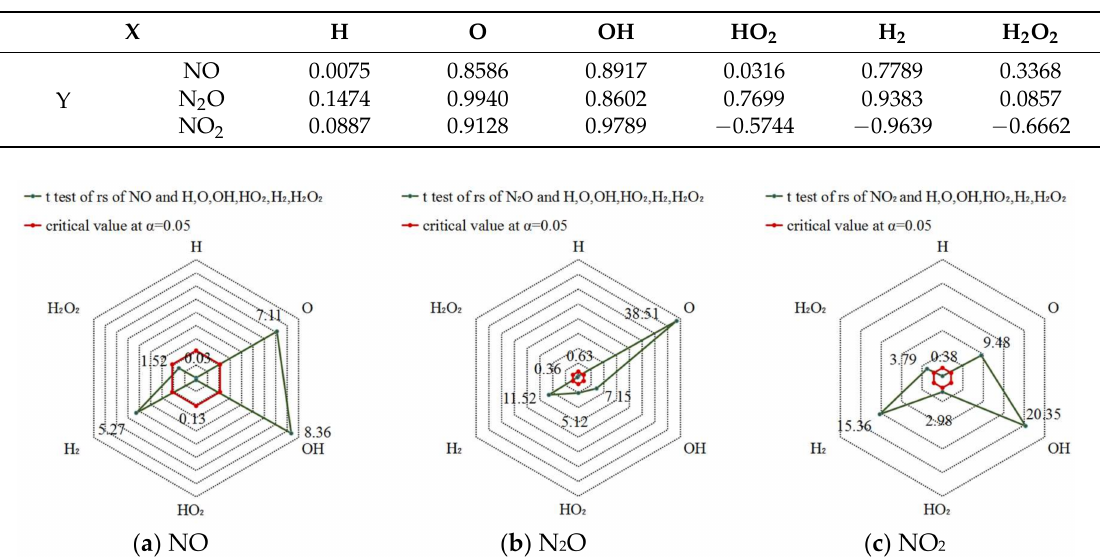
Table 3. SRCC matrix of free radicals mole fraction and maximum reaction rate of NO x .